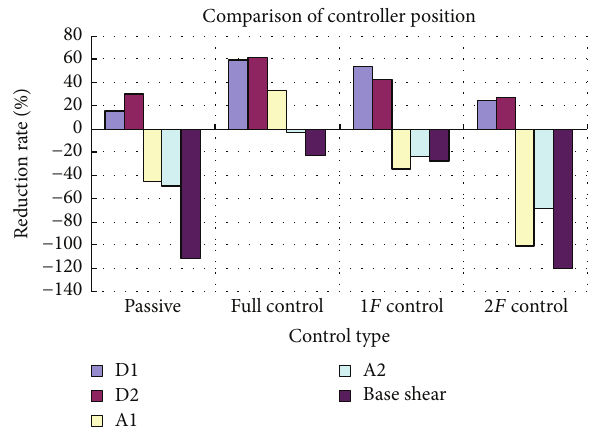
Figure 19: Comparison of shock absorption ratios of the test structure with different control types under excitation of the Kobe